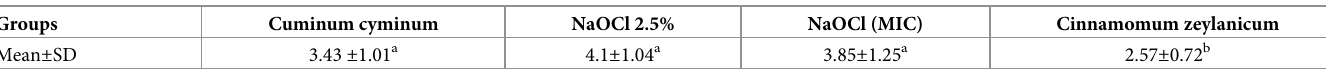
Table 2. The mean ± standard deviation of the push-out bond strength of each group. Groups